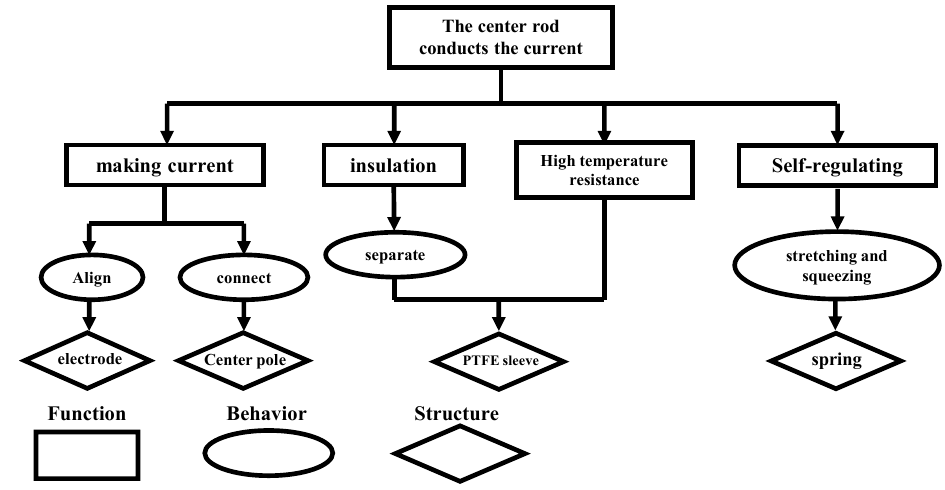
Figure 14. Functional behavior structure diagram of the electrified center pole.